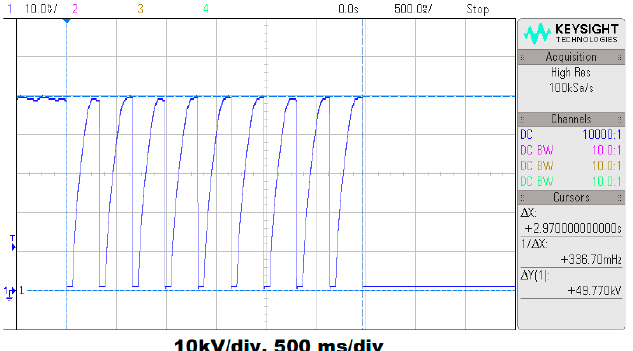
Figure 17. Capacitors discharging and recharging process when ten pulses with an interval of 330 ms were generated.